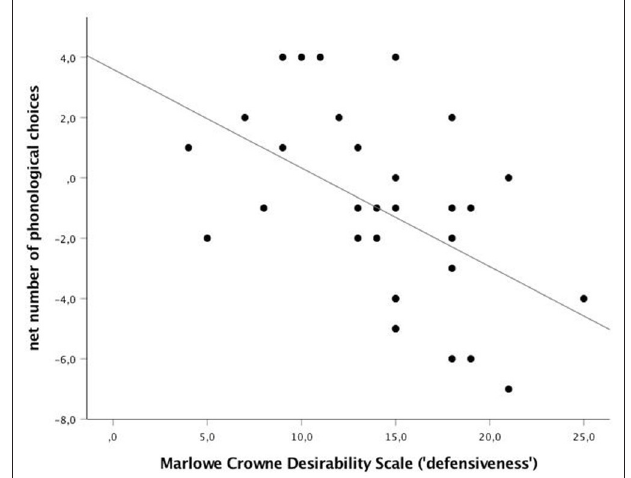
FIGURE 1 | Low defensive participants make phonological choices, high defensive people avoid them. Net number of phonological choices (experimental–control) in function of the Crowne-Marlowe Social Desirability scores ( r = − 0.51; p = 0.004; N = 31). The less “defensive,” the more net phonological choices made by the participant in a fully subliminal priming experiment with tachistoscopic presentation of both prime and target at 1ms; Experimental the participant’s task was to pick the target choice which was most similar to the target, choosing between a phonological reversed target (e.g., “DOOR” and “ROAD”) and a non-related target (e.g.,